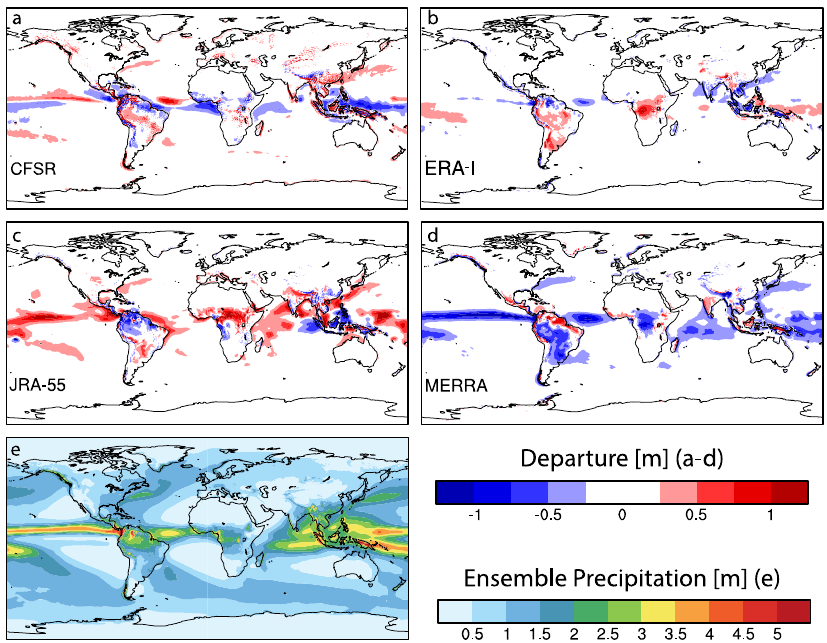
Figure 6. ( a – d ) Gridded differences in precipitation for each reanalysis model subtract ( e ) the ensemble mean annual precipitation over the 1981–2010 period.